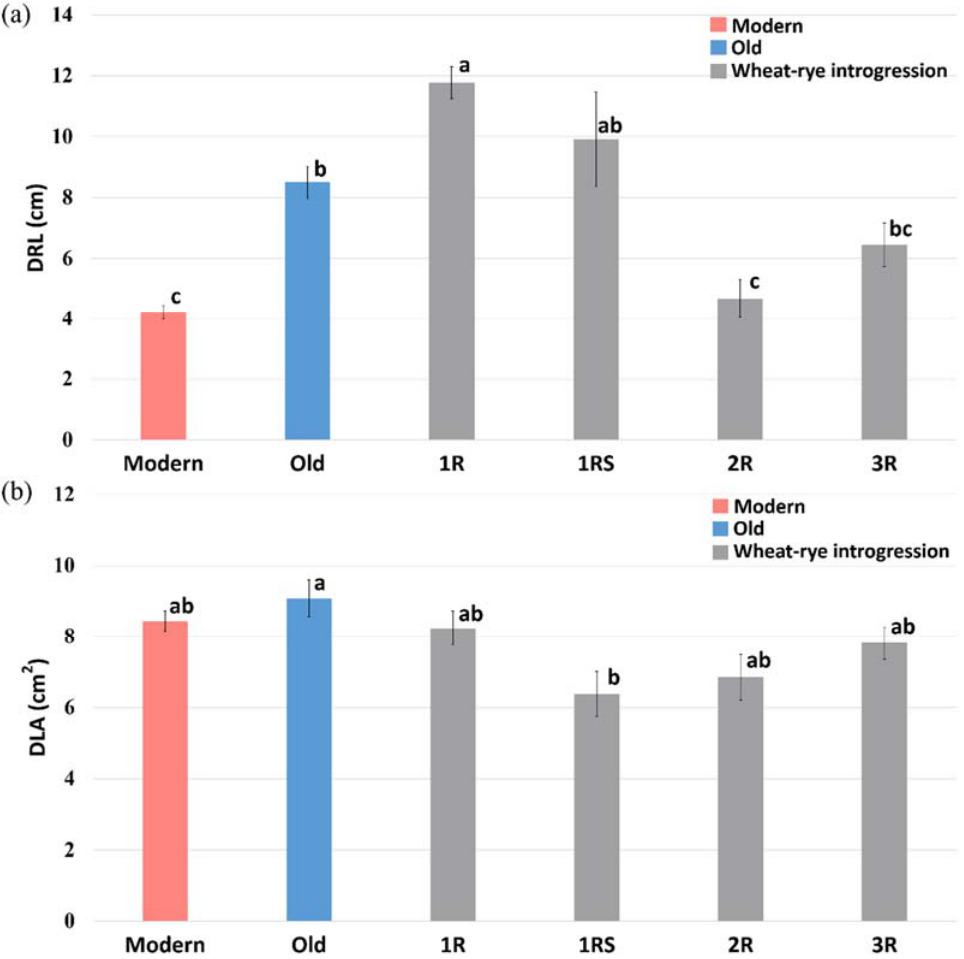
Figure 1. Comparisons of early crop vigour measured as ( a ) digital ‐ root length (DRL) and ( b ) digital ‐ leaf area (DLA) in spring ‐ wheat lines of different genetic background, including modern lines, old Swedish lines and wheat ‐ rye introgression lines with different chromosomes from rye. The results of Tukey post ‐ hoc test are presented by applying a compact letter display at p < 0.05. Modern = approved cultivars and breeding lines received from company Lantmännen, Old = cultivars released from 1928 to 1990, 1R = introgressions of chromosome 1R, 1RS = introgressions of chromo ‐ some 1RS, 2R = introgressions of chromosome 2R, 3R = introgressions of chromosome 3R.